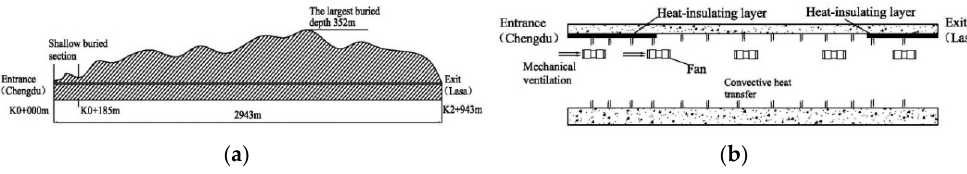
Figure 3. Longitudinal section and the air-lining heat transfer model of the Dege tunnel. ( a ) Longitudinal section of Dege tunnel (K0 + 000 m–K2 + 943 m) and ( b ) The air-lining heat transfer model of Dege tunnel (mechanical ventilation in the longitudinal direction).